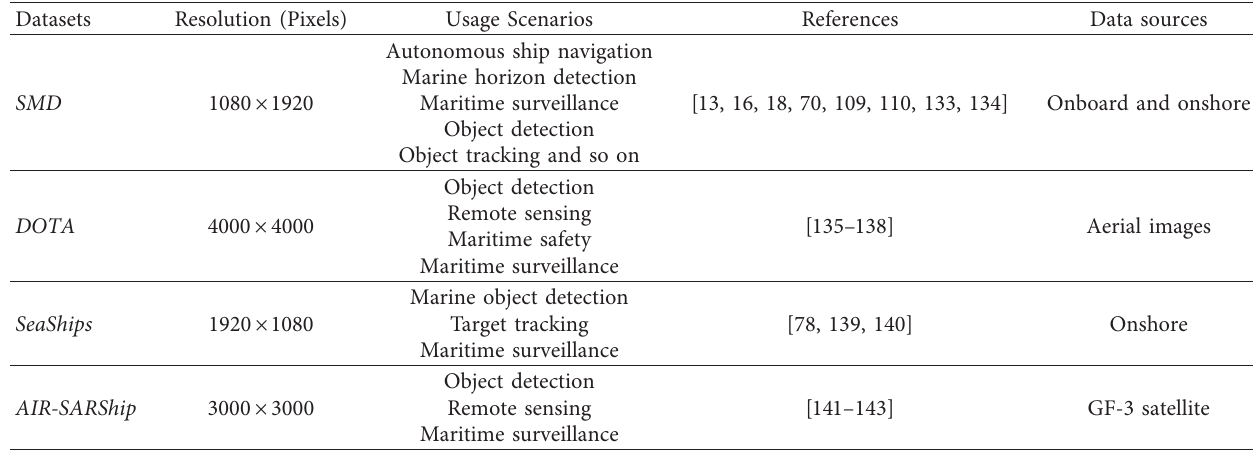
Table 3: Comparison of representative marine object detection